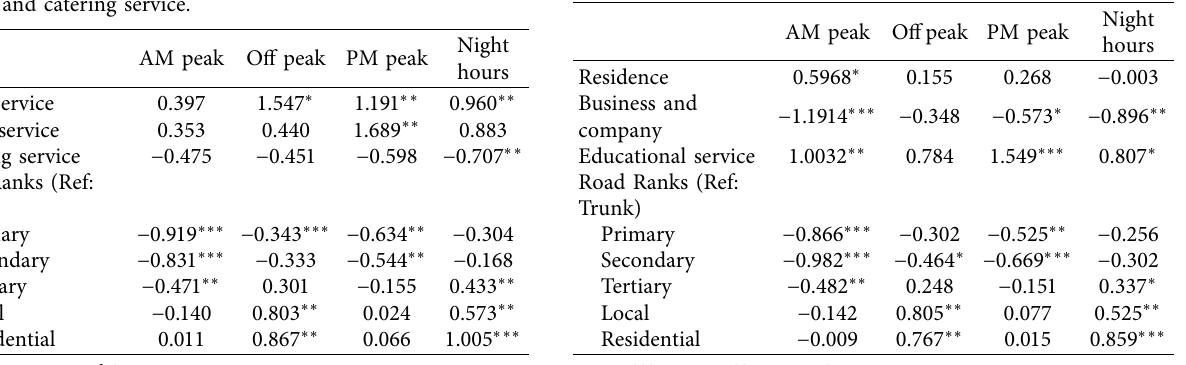
Table 7: Impact of daily commuter POIs on road congestion. Table 6: Impact of POIs on road congestion in retail service, living